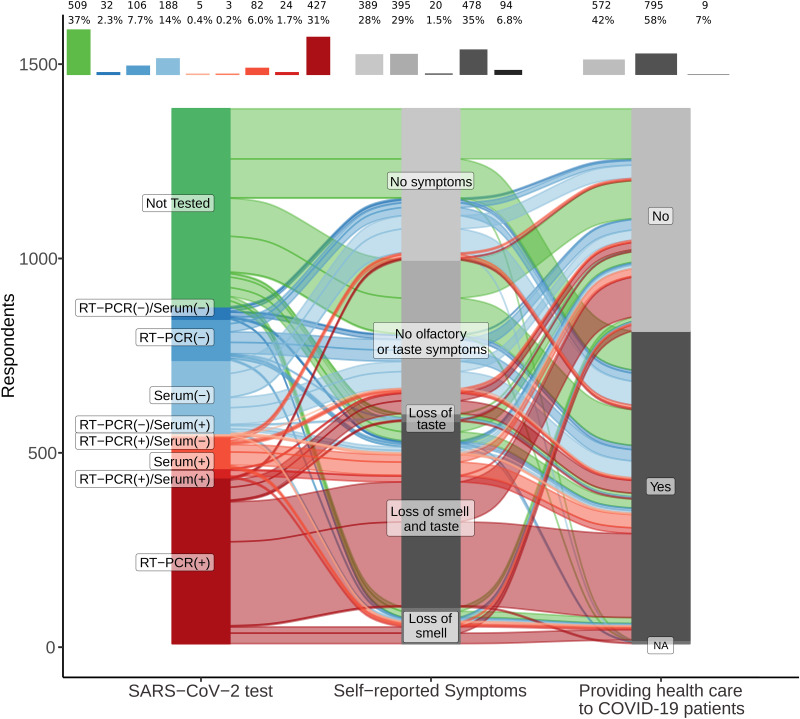
Loss of smell is associated with severe acute respiratory syndrome coronavirus 2 (SARS-CoV-2)-positive testing in professionals providing health care to coronavirus disease 2019 (COVID-19) patients. Alluvial diagram depicting SARS-CoV-2-positive respondents (shades of red) as the dominant proportion of those who self-reported loss of smell, combined or not with loss of taste. A higher proportion of participants tested positive in the group providing health care to COVID-19 patients. In contrast, SARS-CoV-2-negative (shades of blue) and not-tested (green) participants reported other symptoms or no symptoms more often than SARS-CoV-2-positive respondents. Frequency and percentages of each block are reported at the top of the diagram. Correlations between individual answers are represented as flows between one block to another (each block in the same column represents a different answer for the same question). The larger the width of a flow, the larger is the number/proportion of correlated answers from different questions. Questions (Q)/answer (A) pairs were (from left to right): (1) Q – Have you been tested for COVID-19? A – Yes or no (specify test method); (2) Q – Are you feeling or have you felt any of these symptoms in the last days? / A – Answers to loss or reduction of smell or taste were aggregated as “loss of smell,” “loss of smell and taste,” “loss of taste,” “no olfactory or taste symptoms,” “no symptoms”; (3) Q – Are you providing direct care to patients with COVID-19 diagnosis? / A – Yes or no. NA: not answered.